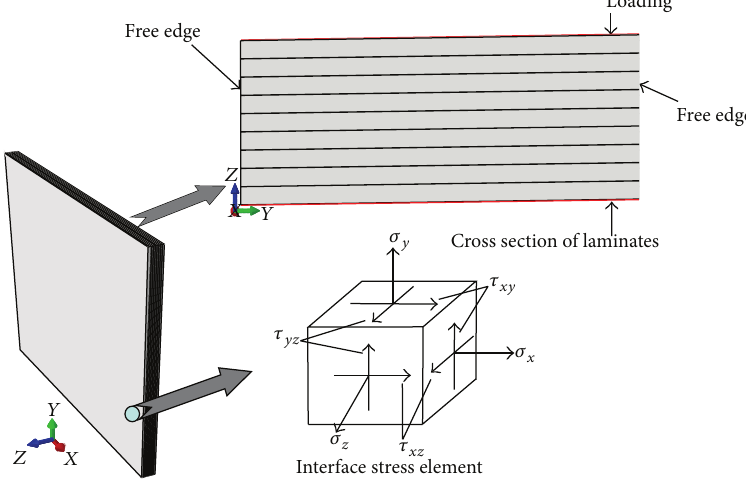
Figure 3: Model of CF/EP laminates and interface stress element.